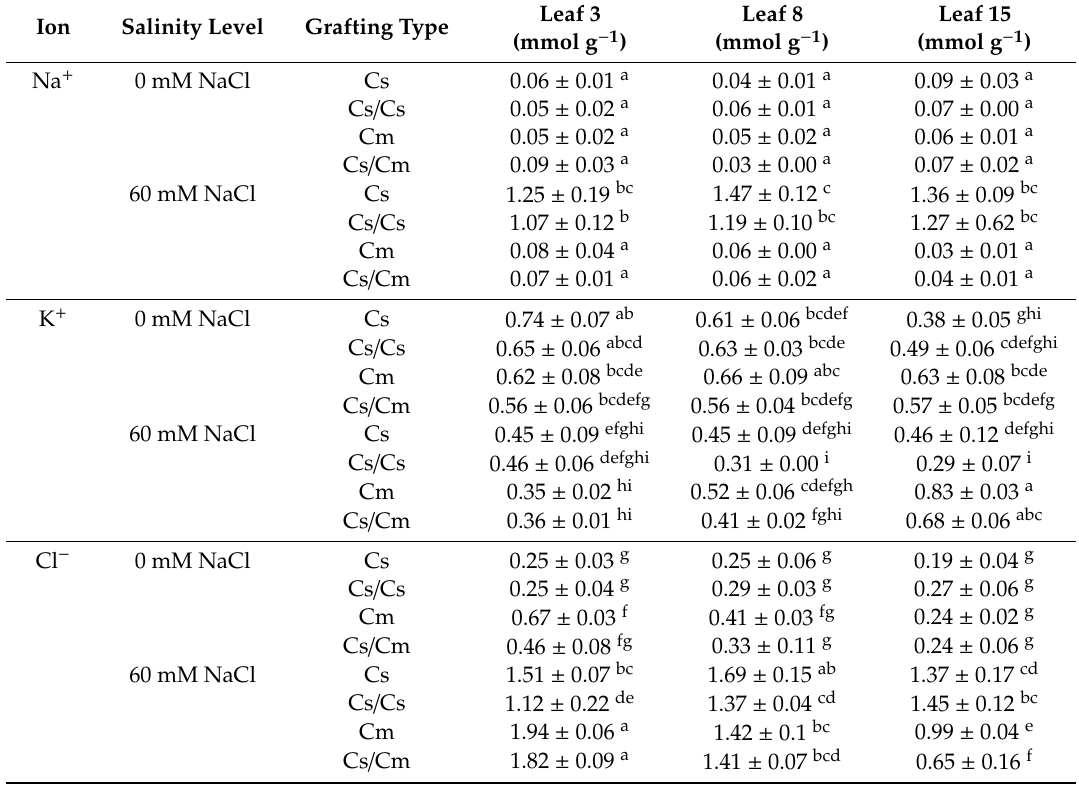
Table 4. Influence of grafting on the ion concentrations in di ff erent leaves on day 23 after salinity